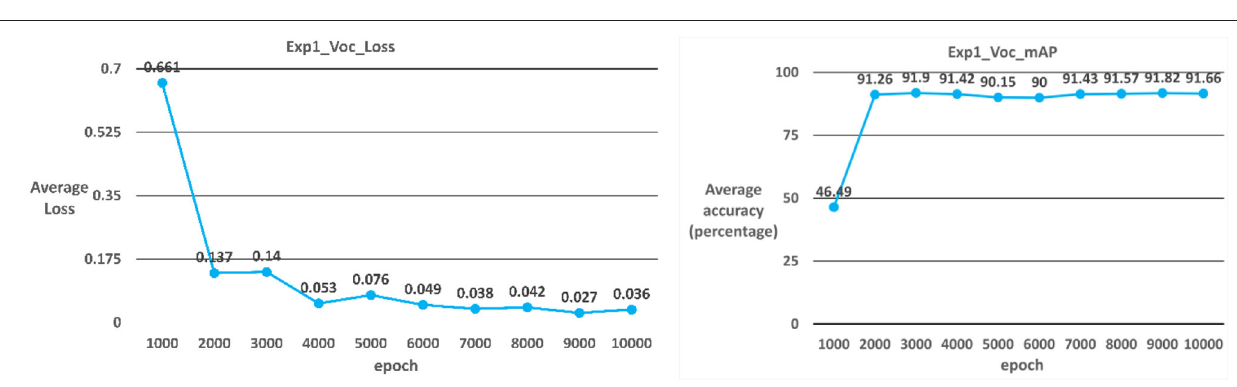
FIGURE 7 | YOLOv3_voc average error rate and average accuracy rate.